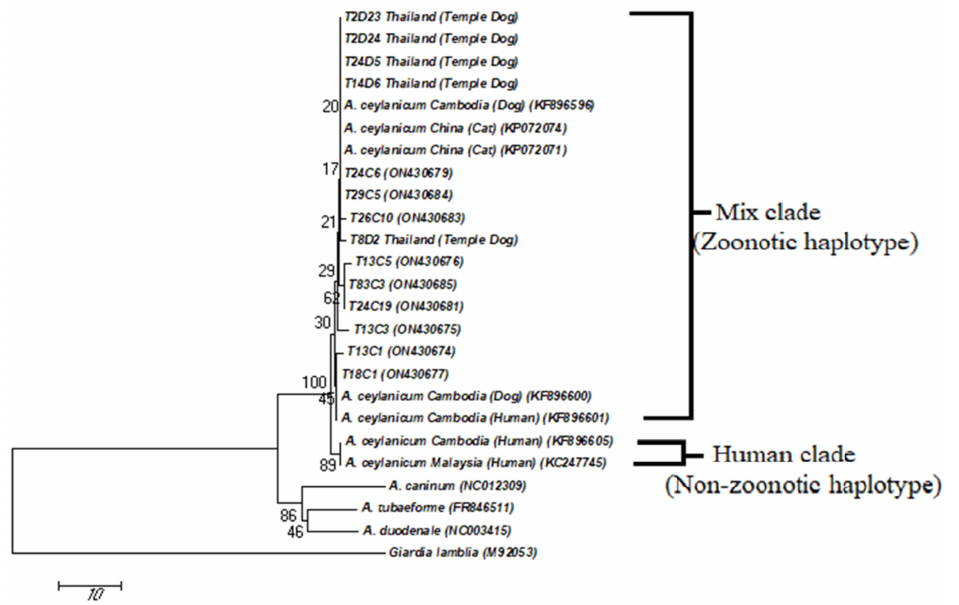
Figure 2. Phylogenetic tree of A. ceylanicum based on the nucleotide sequences of a 377-bp fragment of cox 1 gene by the maximum likelihood (ML) methods (Tamura-Nei parameter model). Number at each branch represents percentage occurrence of clades based on 1000 bootstrap replications of data, with Giardia lamblia provided as